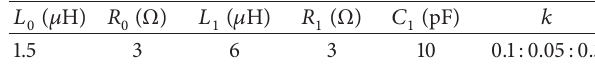
Table 1: Initial values of the antenna and the LC circuit.